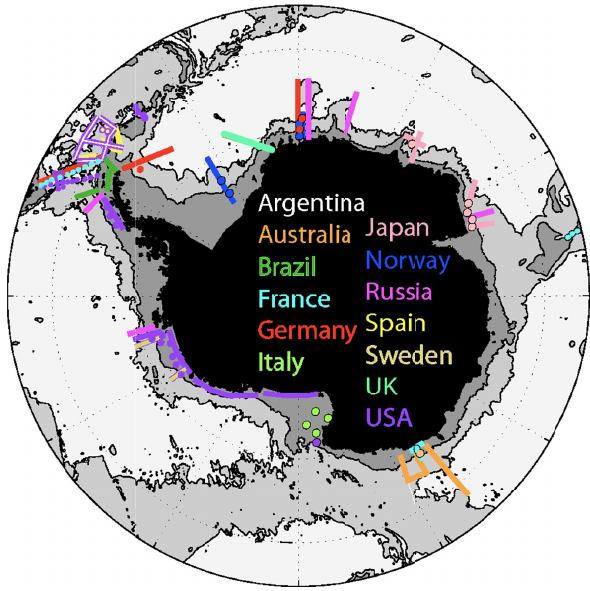
Fig. 1. A schematic summary of the activities (moorings and CTD sections) undertaken as contributions to the SASSI programme.